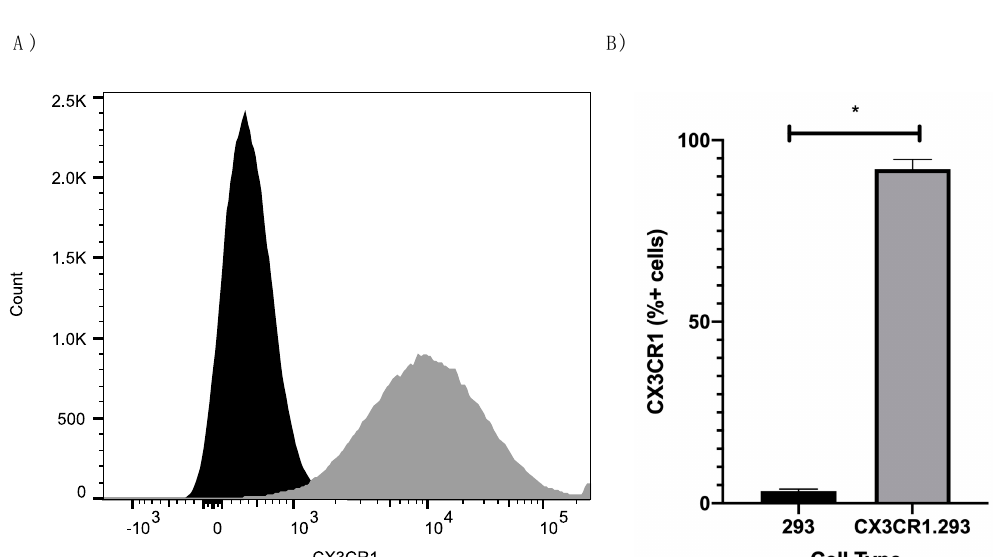
Figure 5. CX3CR1.293 cells abundantly express CX3CR1. Representative histogram ( A ) and percentages (B) of CX3CR1 expression in 293 (black) and CX3CR1.293 (gray) cells after staining with anti-CX3CR1-Alexa647. 20,000 events were collected. Bars represent the mean of three independent experiments + SEM where * p < 0.001 by two-tailed T test.